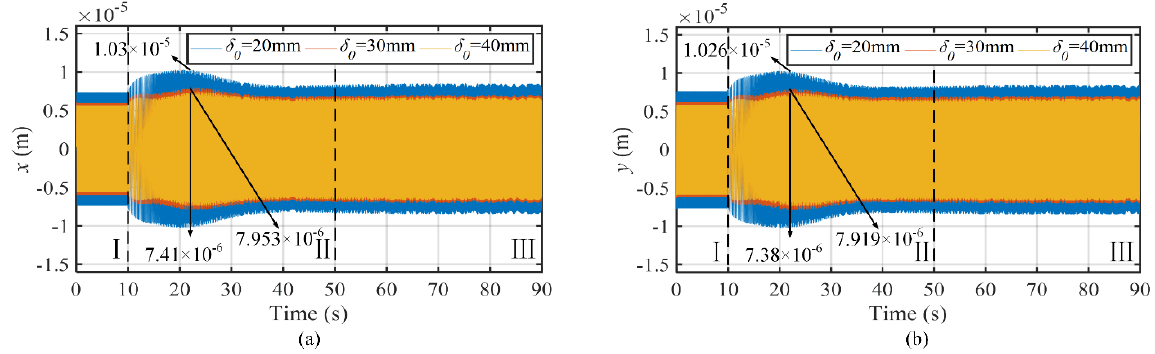
21 of 24 Figure 18. The time-domain figure of the generator rotor under different excitation currents. ( a ) In x -direction; ( b ) in y - direction. Figure 19. The axis trajectory of the generator rotor under different excitation currents. ( a ) 50% I j ; ( b ) 75% I j ; ( c ) 100% I j . As can be observed in Figures 18 and 19, when t = 21 s, the maximum vibration re- sponse occurs at the generator rotor. When 75% excitation current is conducted, the vibra- tion amplitudes of the generator rotor in x -direction and y -direction are the largest, which increase by 40% and 34.67%, compared with that of Area I, respectively. The axis trajectory and vibration amplitude at the generator rotor increase as the excitation current increases. (2)